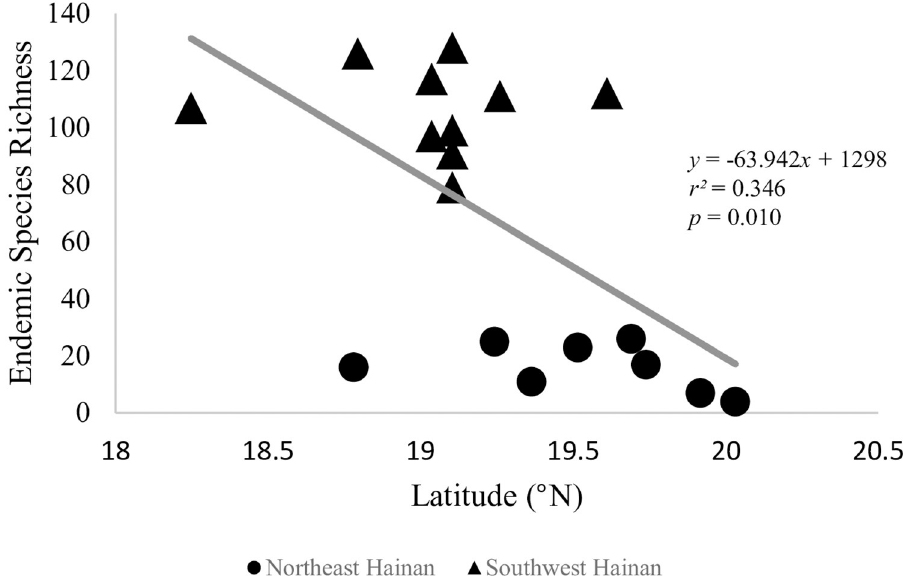
Fig 3. A linear regression analysis revealed that there was a weak but significant negative correlation between species richness and latitude across Hainan (r2 = 0.346, p = 0.010; Fig 3).